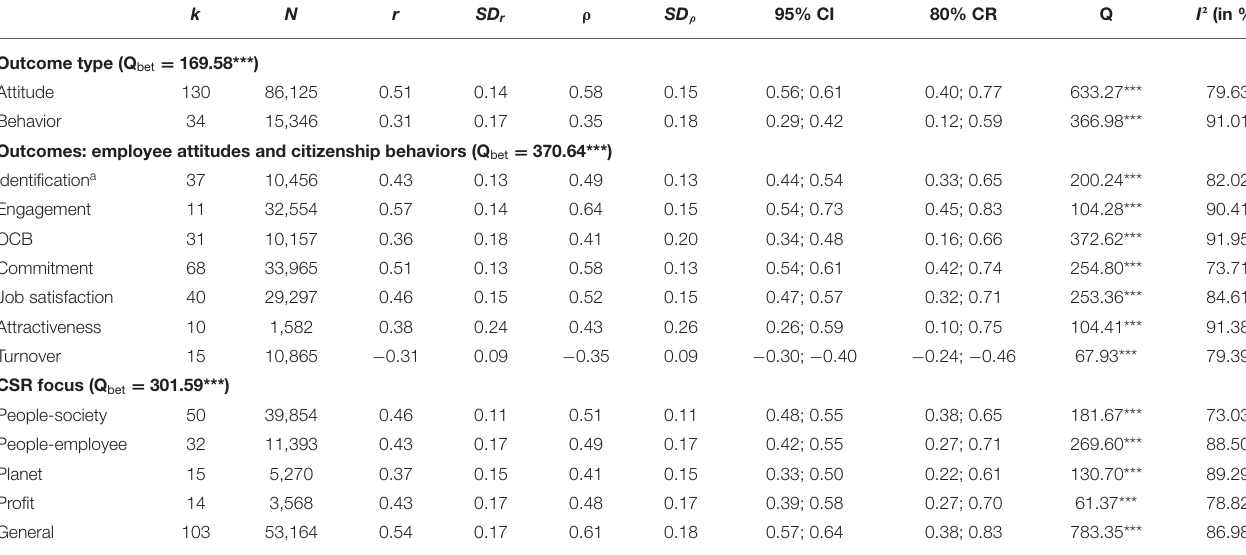
TABLE 2 | Subsample analyses for employee-related outcomes and CSR dimensions.